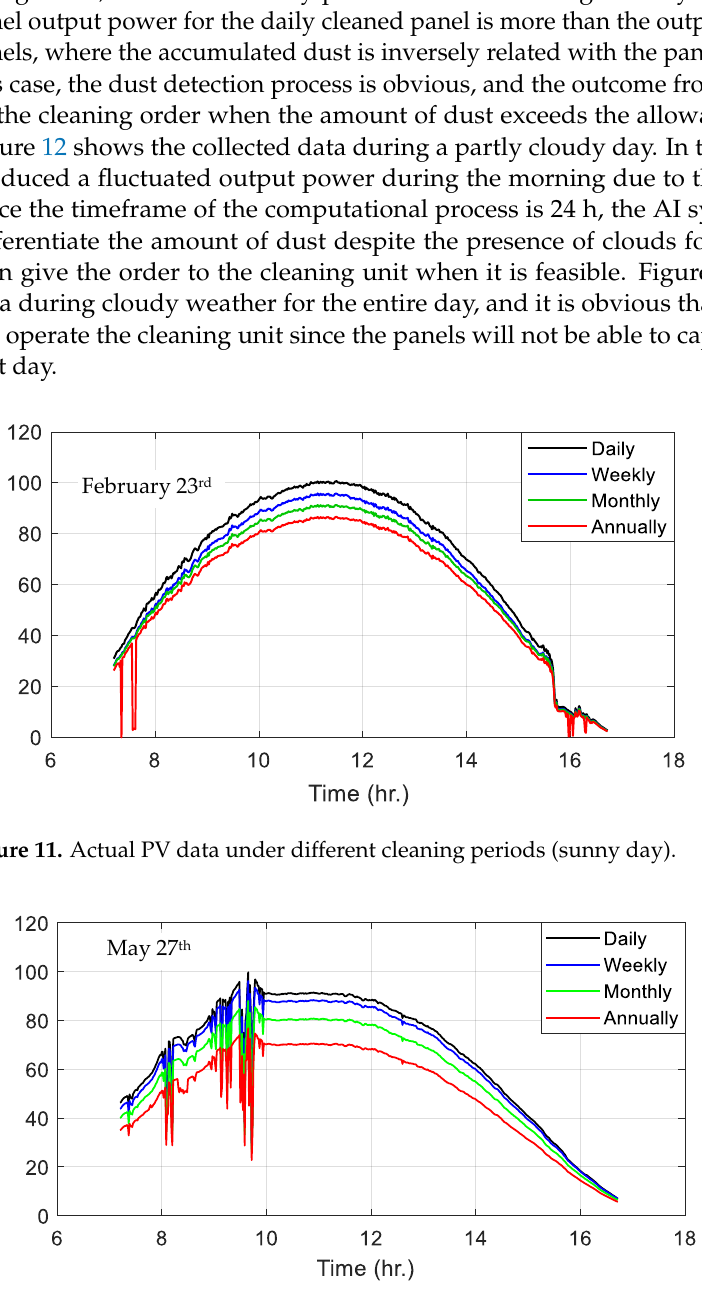
Figure 13. Actual PV data under different cleaning periods (cloudy day). 6. Evaluation of the Estimating Model In the interest of validating the proposed assessment tool, an evaluation analysis was conducted to test the outcomes of the sun energy predictor. Three days were selected care- fully (beginning, middle, and end of the year) to cover all possible sun angle conditions. Figure 14 and Figure 15 show the sun energy estimation for the Riyadh region on February 23 rd , May 27 th , and November 22 nd . Figure 14 shows the estimated sun energy on a flat surface, while the results in Figure 15 are for a surface with a 24-degree tilt angle and 10- degree azimuth angle toward the south. These predicted curves and those for all remain- ing days will be utilized to estimate the PV output power and then detect the dust level with the help of the AI system. It is worth mentioning that the power scale of the estimated sun energy is in W/m 2 ; hence, it is necessary to normalize it (in scale of 100%) to be compatible with any size of